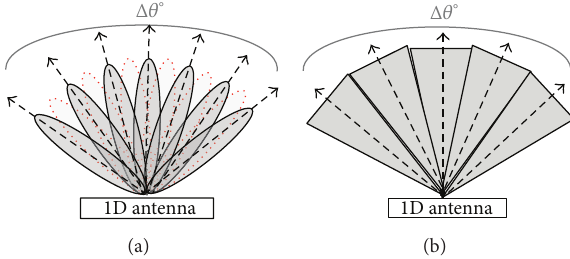
Figure 11: Illustration of (a) Gaussian beams and (b) sectorial beams for beam steering scenario.